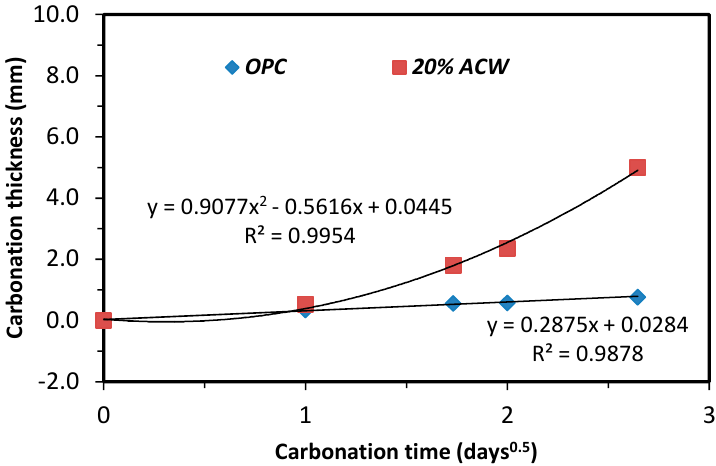
Figure 2. Depth of carbonation front vs. square root of exposure time.